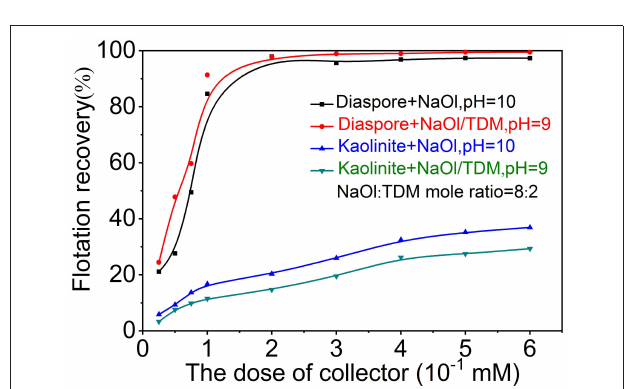
FIGURE 5 | Effect of collector dosage on the diaspore and kaolinite flotation recovery with NaOl (pH = 10) or NaOl/TDM (pH = 9, NaOl: TDM mole ratio = 8:2) as collector.